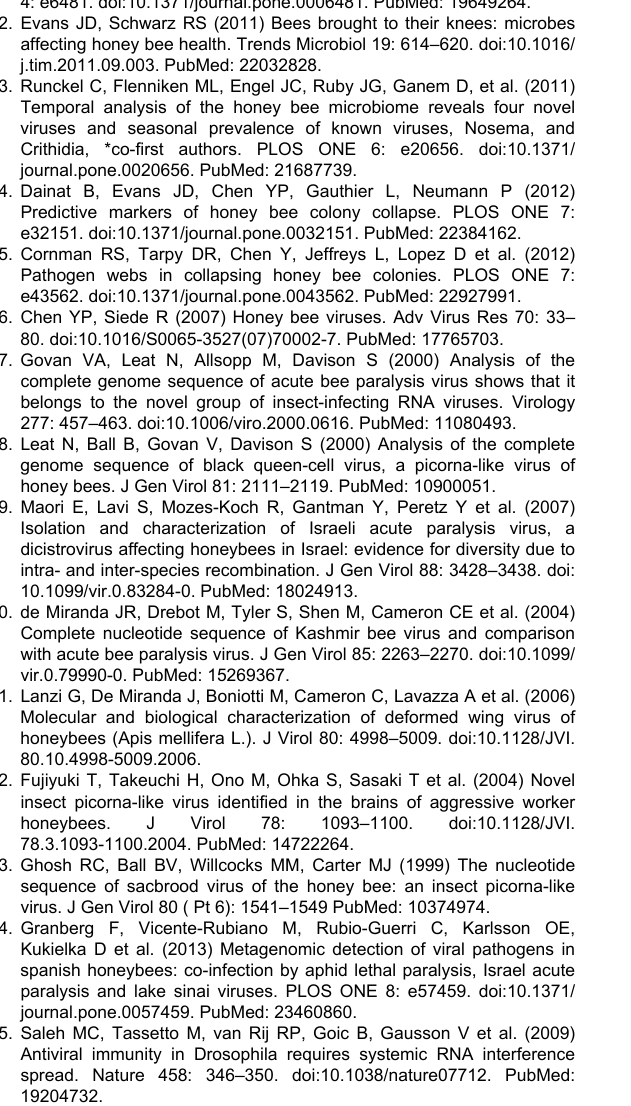
Table S7. Analysis of the expression of characterized insect immune genes in virus-infected and dsRNA-treated honey bees.